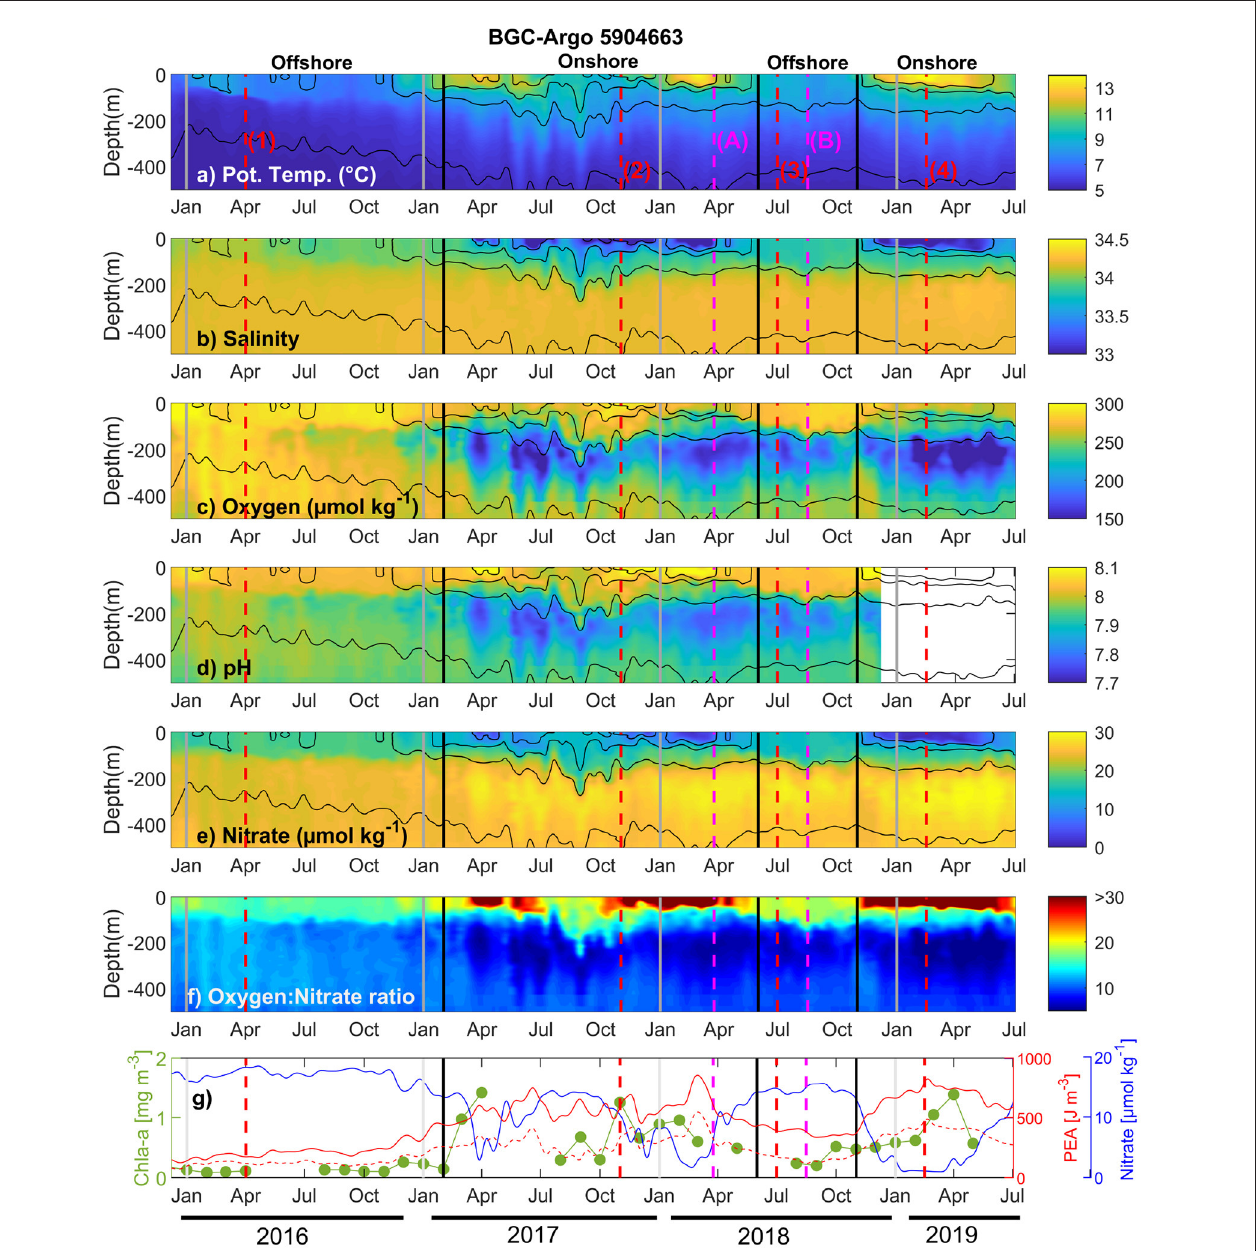
FIGURE 2 | Evolution of the upper ocean (top 500 m) (a) potential temperature, (b) salinity, (c) oxygen, (d) pH, (e) Nitrate, (f) Oxygen:Nitrate ratio, (g) surface Chlorophyll-a (Chl-a; green line), Potential Energy Anomaly (PEA) for the upper 250 m (solid red line) and 500 m (dashed red line), and surface nitrate (1 m depth; blue line), along the trajectory of BGC-Argo float 5904663 from December 2015 to July 2019. Black contours denote isopycnals. Vertical red lines indicate the dates of selected T-S diagrams shown in Figure 4 . Vertical magenta lines correspond to the dates of the two HYCOM salinity maps shown in Figure 1a (March 25, 2018) and Figure 1b (August 16, 2018). Vertical black lines indicate the transition from offshore to onshore (and vice versa) and gray lines denote the beginning of each year. The Oxygen:Nitrate ratio is shown between 5 and 30 (range that contain the 96.9% of the data) to facilitate the interpretation. The ratio is presented in positive values (it has been multiplied by − 1 with respect to the Redfield